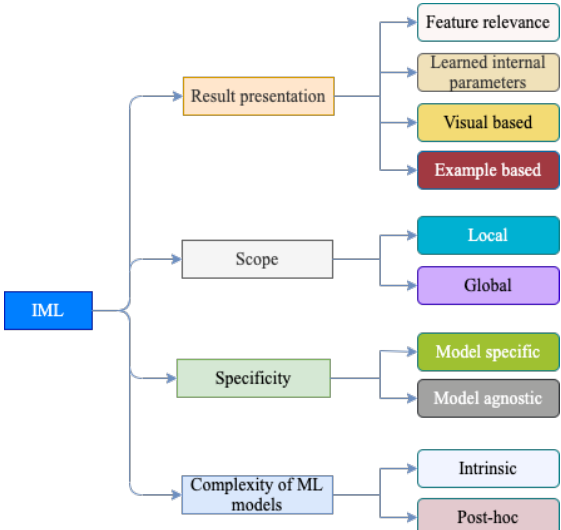
Figure 6. Taxonomy of machine learning